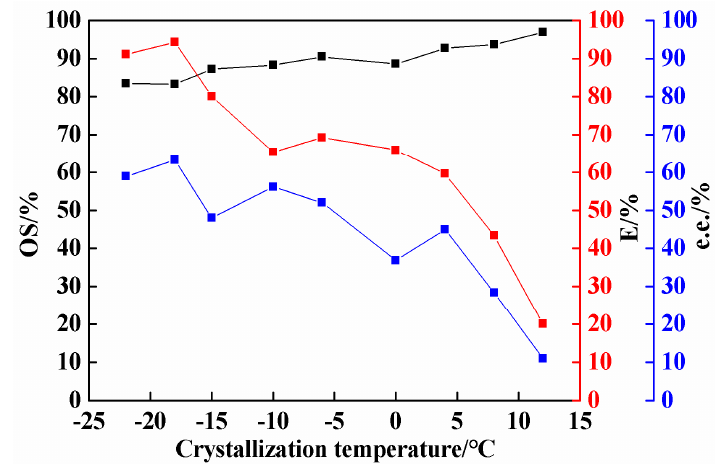
Figure 5. Effect of crystallization temperature on resolution of 3-ClMA by LEV (LEV = 2.84 mmol; 3-ClMA = 2.32 mmol; acetonitrile = 3.5 mL; equilibrium time = 12 days).